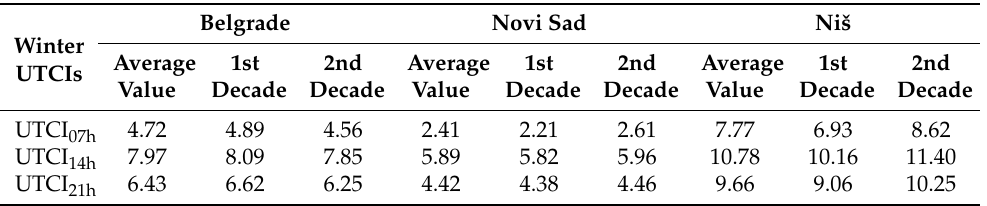
Table 6. Average winter UTCIs values in Belgrade, Novi Sad, and Niš for the period 1999–2018, and